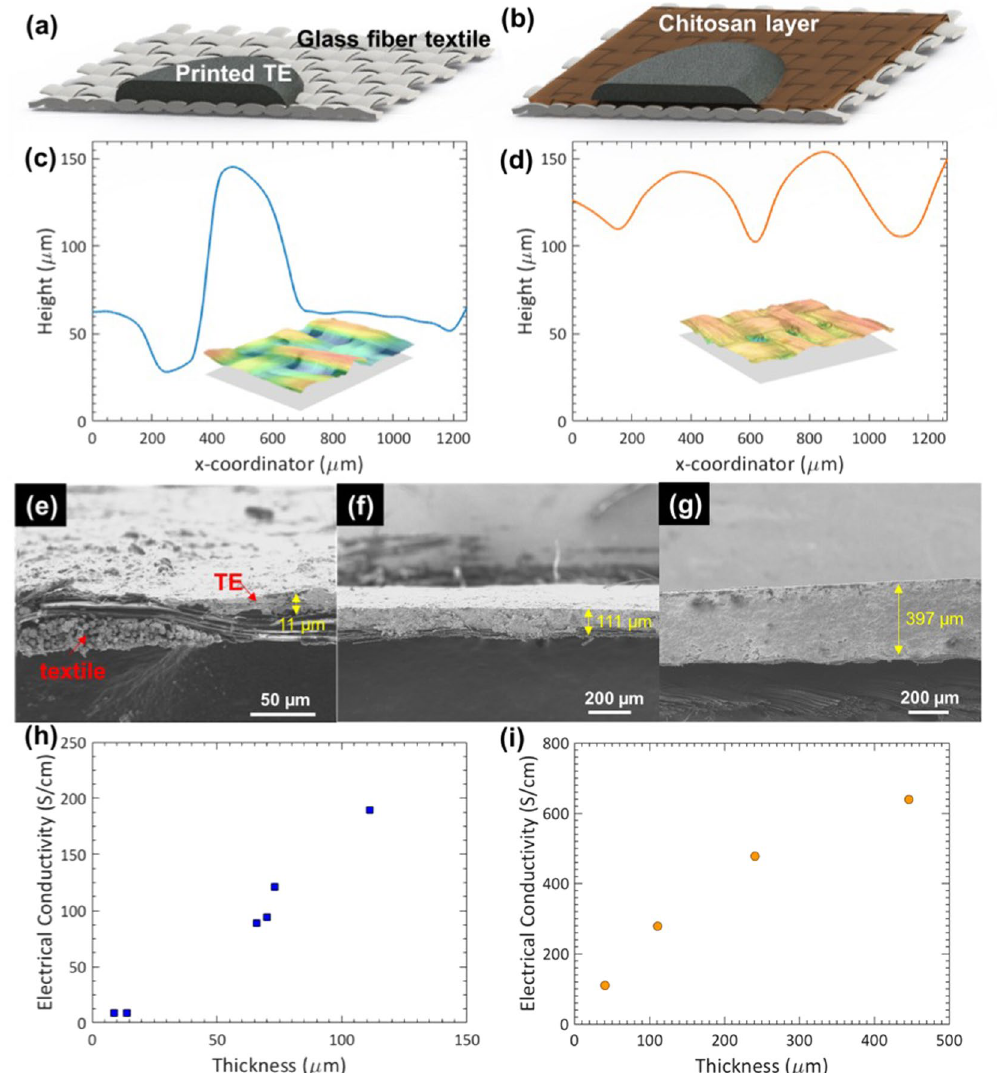
fabric ( c ) and printed Chitosan layer on top of glass fiber fabric ( d ) with their measured 3-dimensional surface images using a Keyence optical microscope (insets). SEM cross-sectional images of printed and hot-pressed samples on fabrics with thickness of 11 µ m ( e ), 111 µ m ( f ) and 395 µ m ( g ). Plots of electrical conductivity as a function of thickness of the printed BST layers without ( h ) and with chitosan ( i